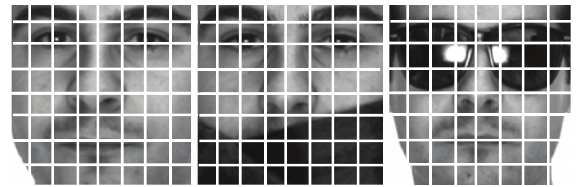
Figure 6: The face images are divided into 64 blocks for selective LGBPHS